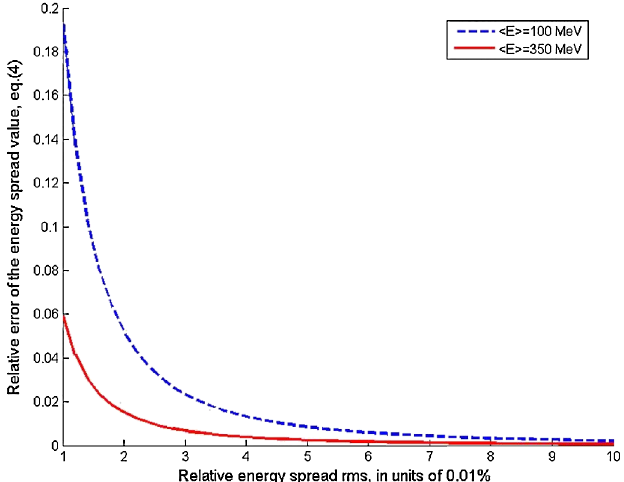
FIG. 7. Relative error of the relative energy spread vs its central value, as depicted in Eq. (4), for the SPBC1 line. The dotted line is for the beam mean energy of 100 MeV, the solid line is for 350 MeV.